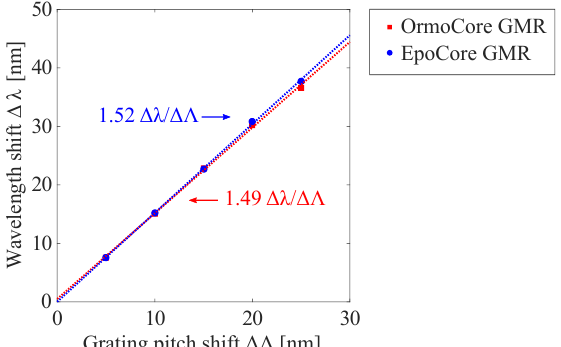
Figure 5. The simulated resonant wavelength shift ∆ λ as a function of the grating pitch shift ∆Λ for the GMR grating in OrmoCore and EpoCore. The used grating parameters are listed in Table 1.